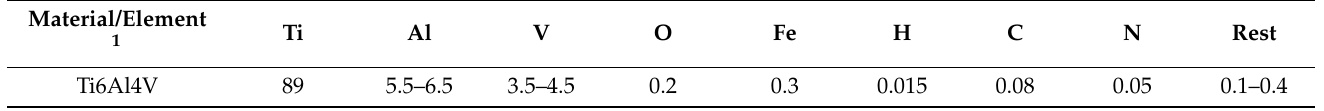
Table 1. Tabular overview of elementary composition (wt%) for Ti6Al4V. Material/Element